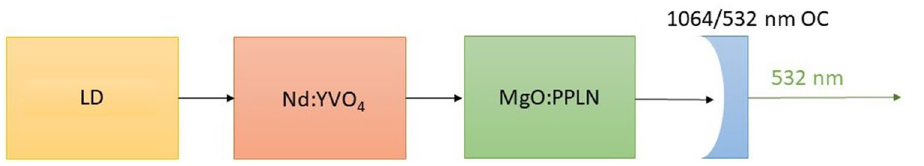
Figure 1. Rough schematic of the LD end-pumped DPSS 532 nm green